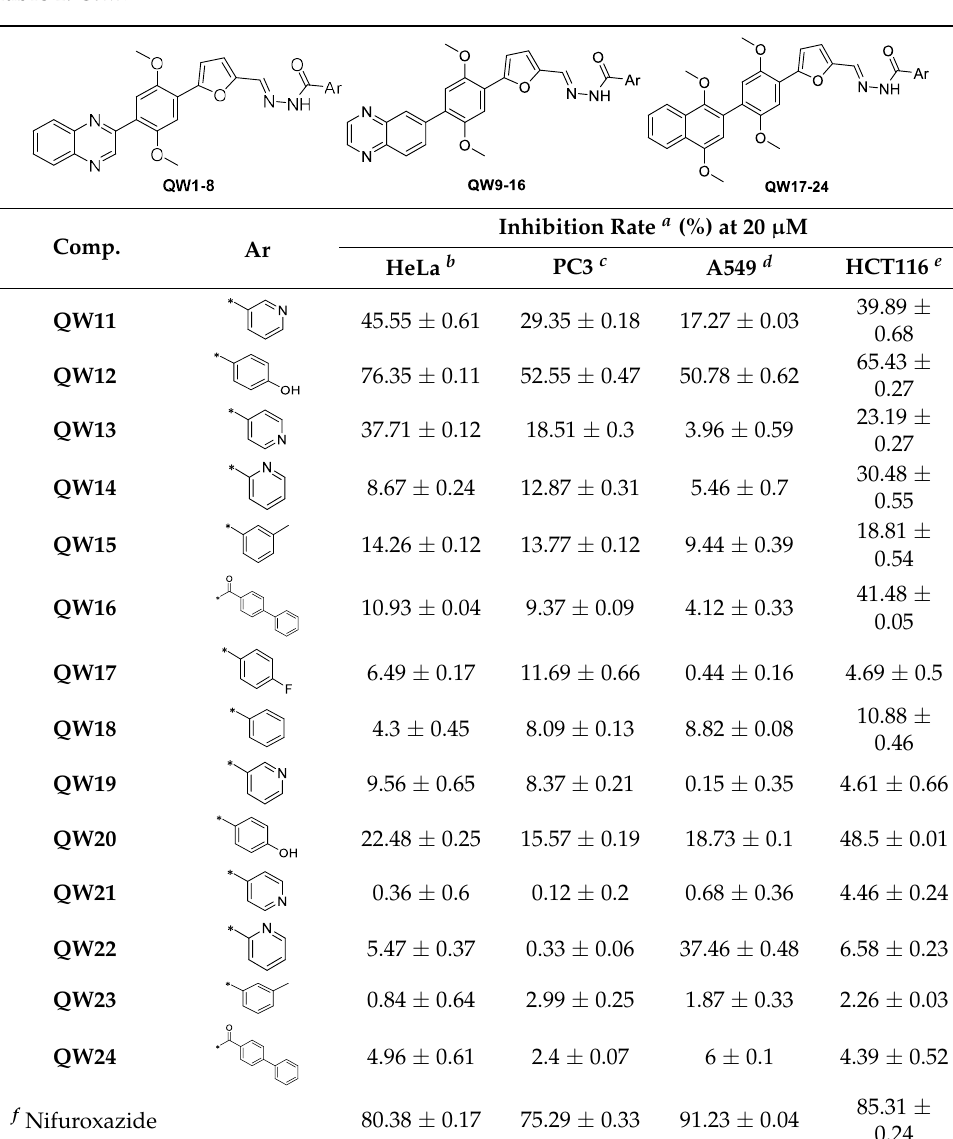
Table 1. Antiproliferative activities of the synthesized compounds against four cancer cell lines.